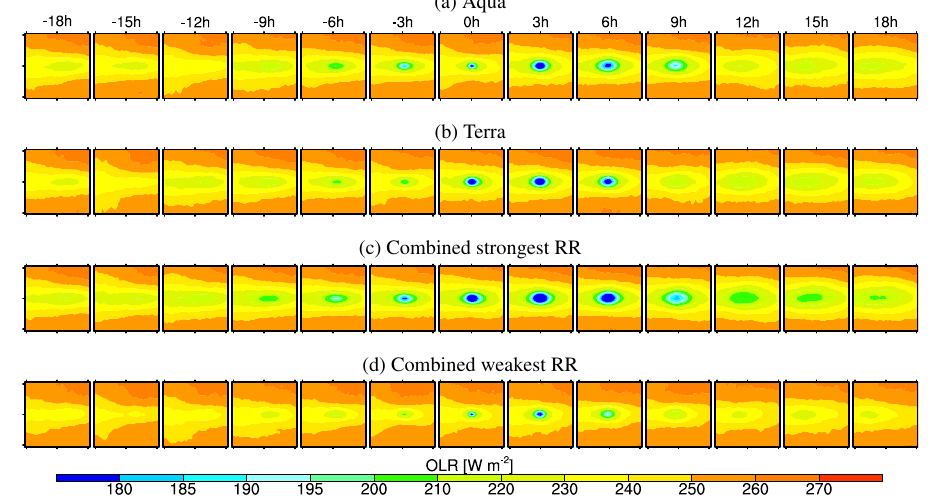
Fig. 1: OLR composite means, averaged as described in Sect. 3.2, from the CERES sensors onboard the sun-synchronous satellites Terra and Aqua. Friezes (a) and (b) show OLR for all DC systems for each sensor separately. In panels (c) and (d) the two sensors are combined, but the DC systems have been divided: frieze (c) includes the top 50 % ( 21 . 6 to 70 . 0 mm h − 1 ) of the 11000 strongest cases, and frieze (d) shows the remainder. The spatial extent of each plot is 12 ° × 12 °.